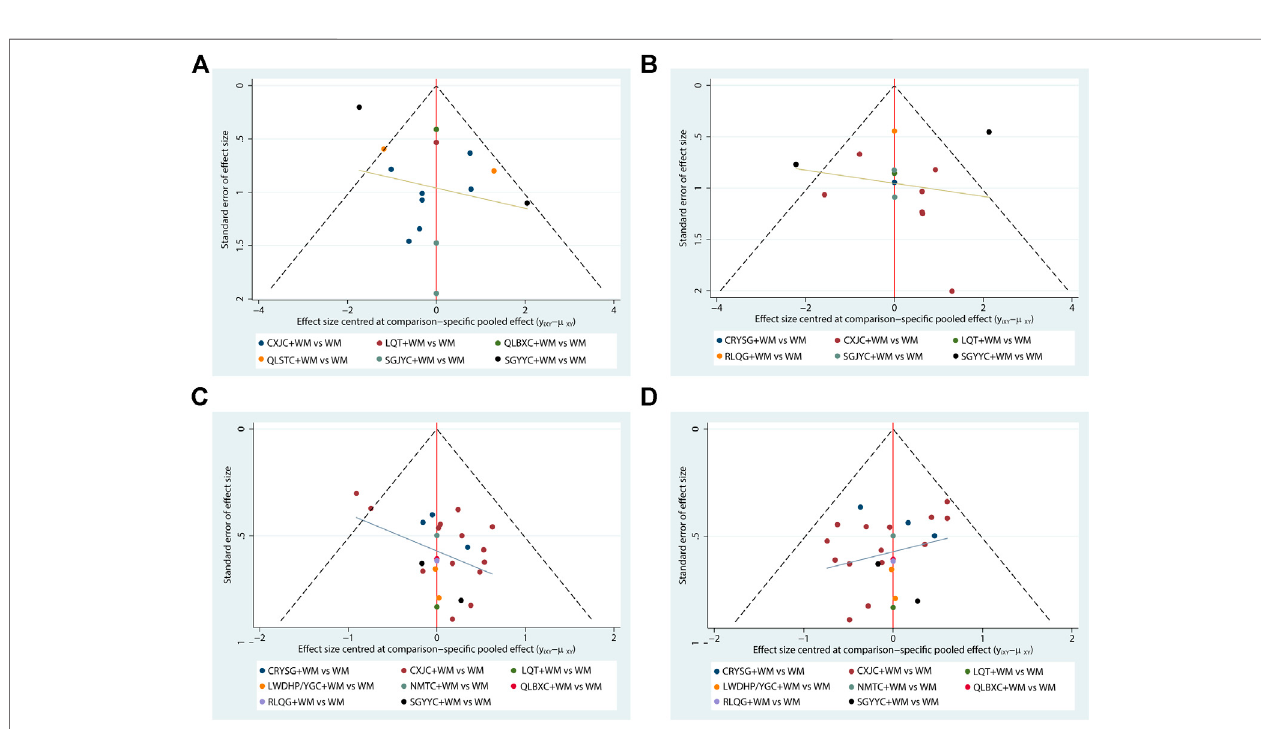
FIGURE 8 | Funnel plots (A) NIH-CPSI; (B) IIEF-5; (C) the clinical effective rate of CP/CPPS; (D) the clinical effective rate of SD.